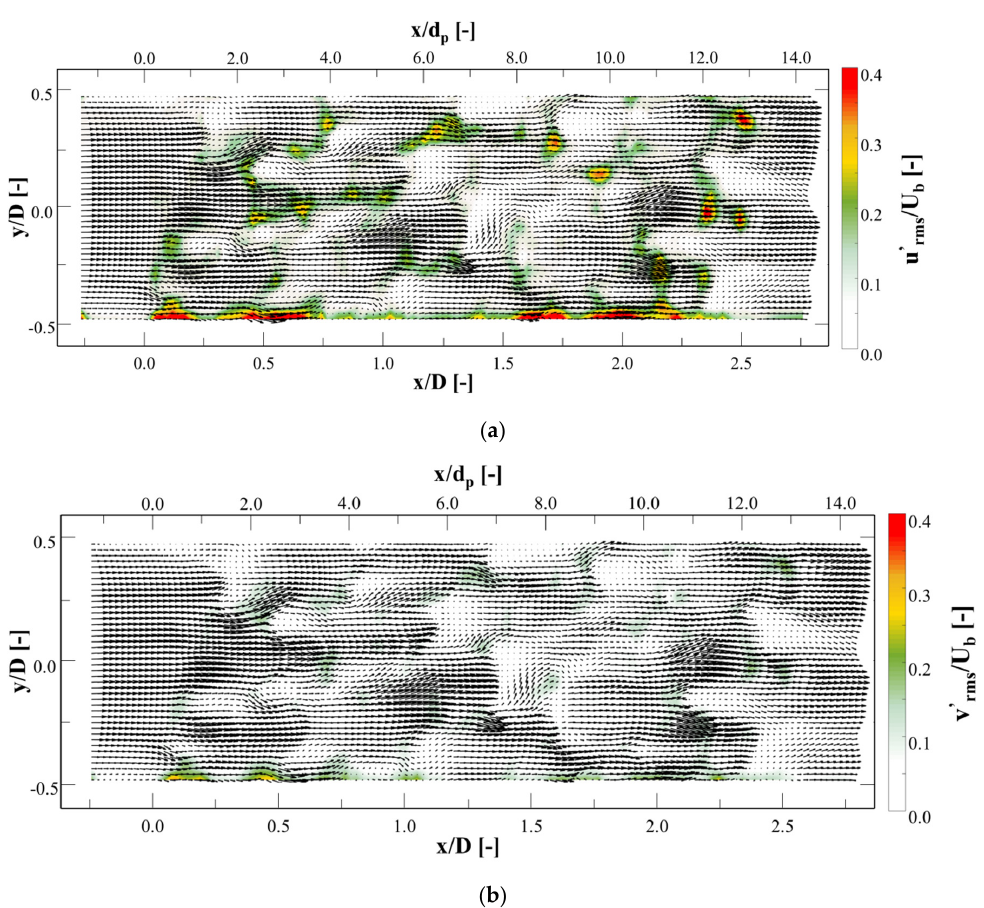
Figure 10. Contours of RMS fluctuation velocities at z = 0 D with superimposed velocity vectors: ( a ) stream-wise ( x -direction) component and ( b ) transverse ( y -direction) component.